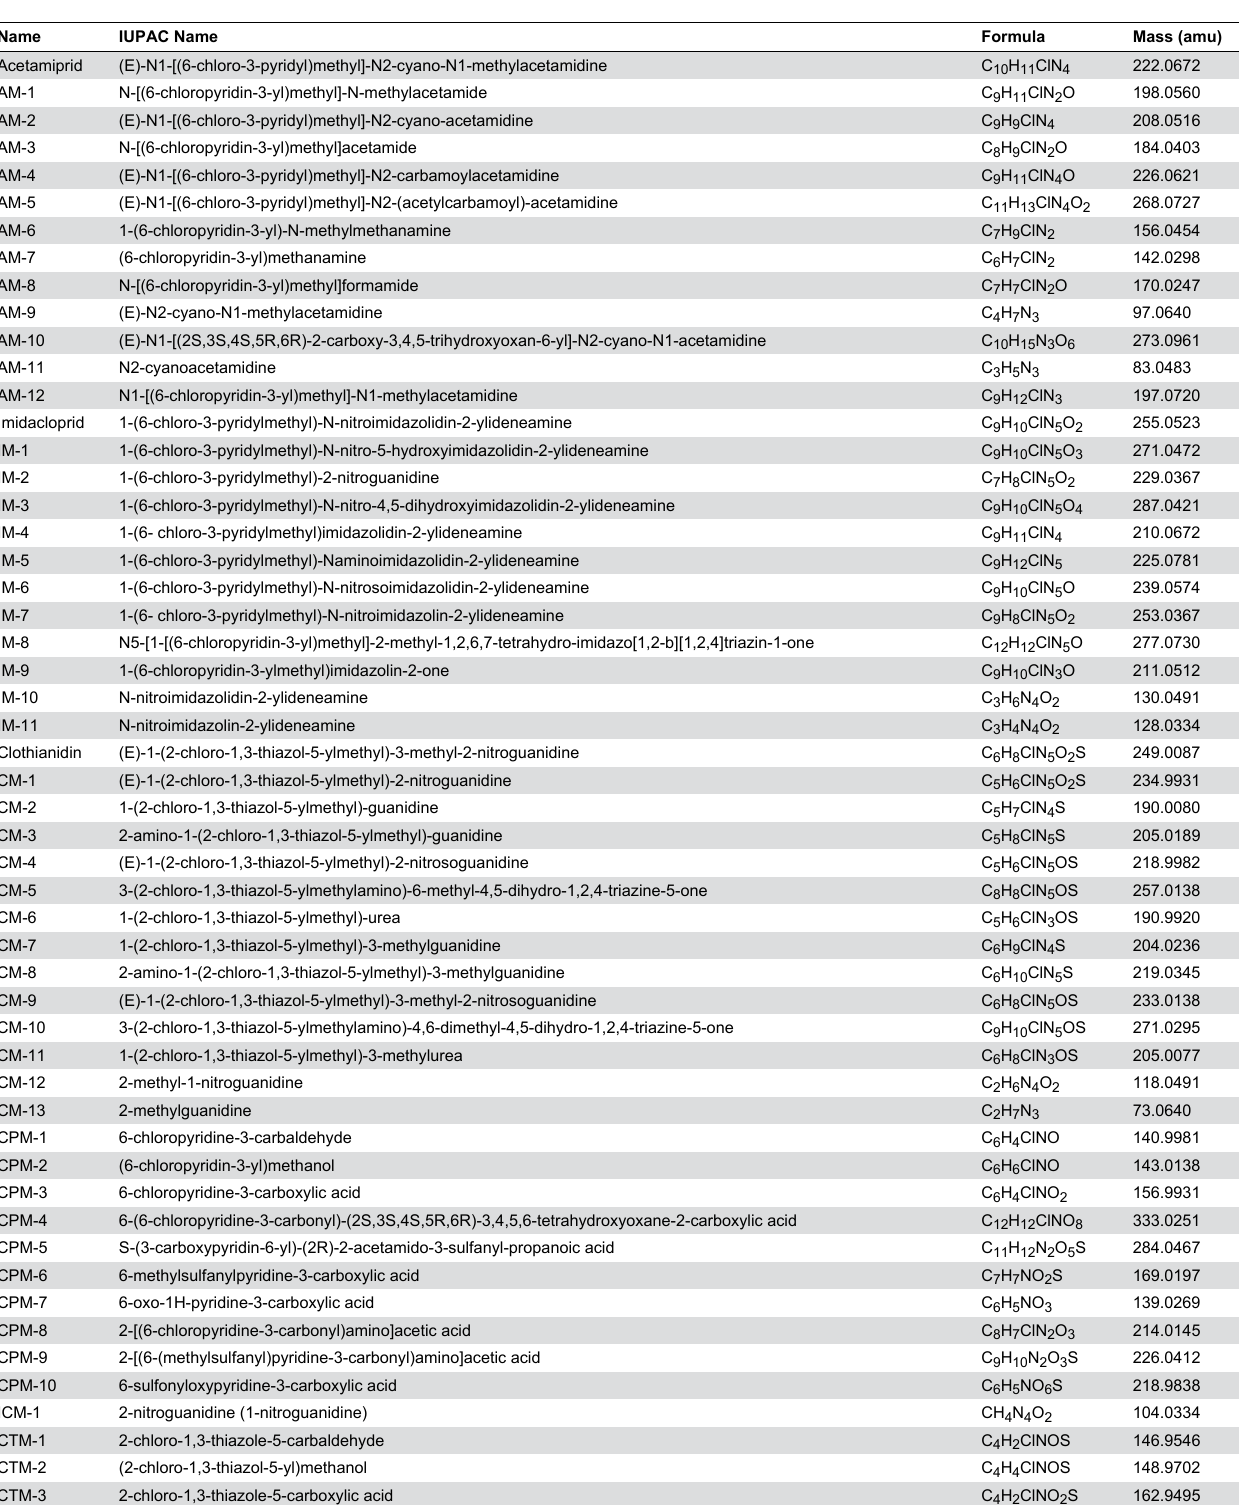
Table 3. The names, IUPAC names, molecular formula and molecular masses of three neonicotinoid pesticides and metabolites used in this